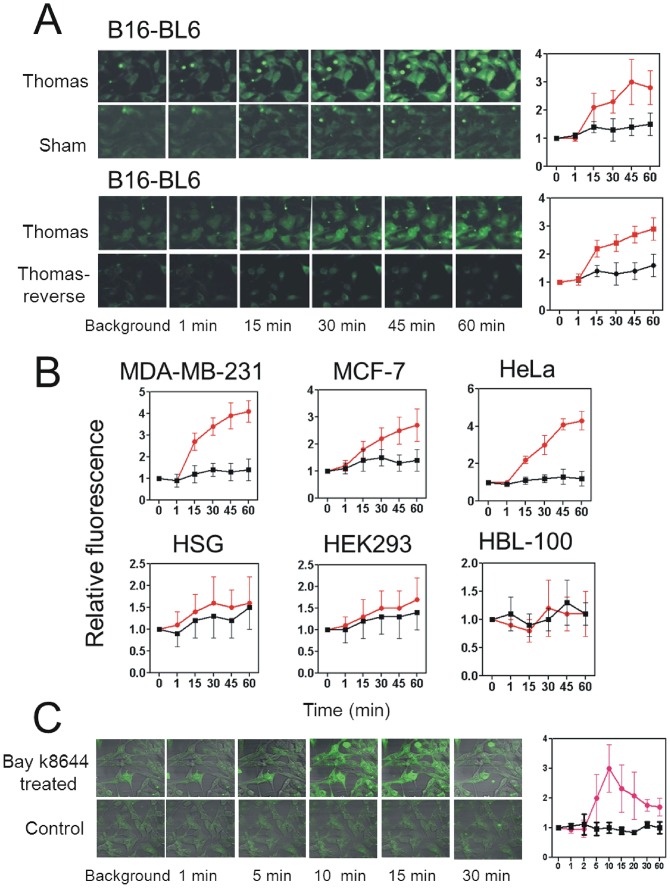
Exposure to Thomas-EMF enhances Ca2+ uptake in malignant cells.A. B16-BL6 cells were cultured on glass coverslips, labelled with the FLUO-4(AM) Ca2+ dye, placed on the microscope stage, and exposed to sham, Thomas-EMF or Thomas-reverse using a single solenoid. The background fluorescence was determined and images taken at 1, 15, 30, 45, and 60 min. The relative fluorescence of the entire microscopic field treated with Thomas-EMF (red) or sham field (black) was determined using MetaMax software and the mean ± SD fold increase for 3 independent experiments plotted as a function of duration of field exposure. B. The relative FLUO-4(AM)-dependent fluorescence was determined for MDA-MB-231, MCF-7, HeLa, HSG, HEK293, and HBL-100 cells treated with Thomas-EMF (red) or sham field (black). The graphs show the mean ± SD fold increase for 3 experiments determined using the MetaMax software as a function of exposure duration. C. B16-BL6 cells on glass coverslips were labelled with FLUO-4(AM) and mounted on the microcope stage. The background fluorescence was determined, the cells treated with 5 μM Bay K8644 and images taken at 1, 2, 5, 10, 15, 20, 30, 40, and 60 min. The relative fluorescence of the cells was determined and the mean ± SD fold change plotted as a function of duration of treatment.